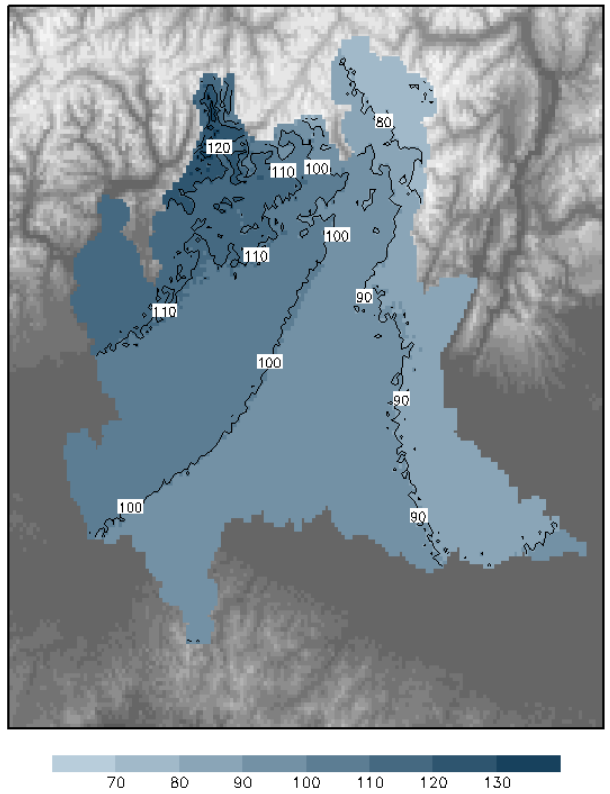
Fig. 8. Map of the rainfall depth threshold h T (mm) for event du- ration D = 3 h and return period T = 200 yr, obtained by applying the proposed method to the complete dataset.